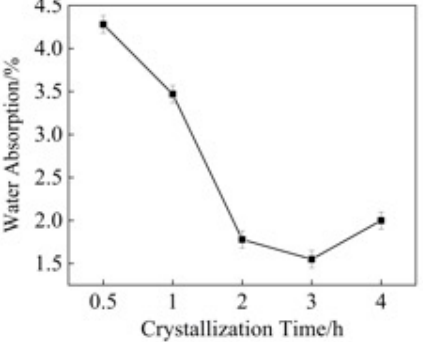
Figure 13. Effects of crystallization time on the water absorption of the microcrystalline glass.